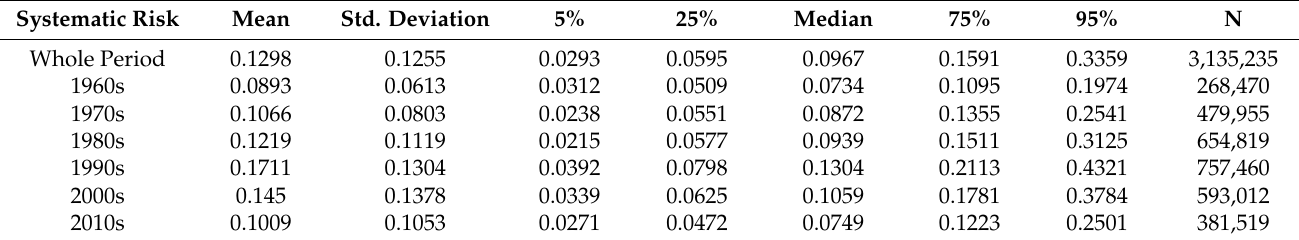
Table 2. Descriptive statistics of idiosyncratic risk. This table presents the descriptive statistics of idiosyncratic risk for individual stocks for the period of July 1963 to December 2019. Within each month, daily stock returns are regressed on the Fama–French three factors. The monthly idiosyncratic risk is the standard deviation of the residual term multiplied by the square root of number of trading days in that month. For each month, a stock should have at least 15 days returns to be included in the calculation.